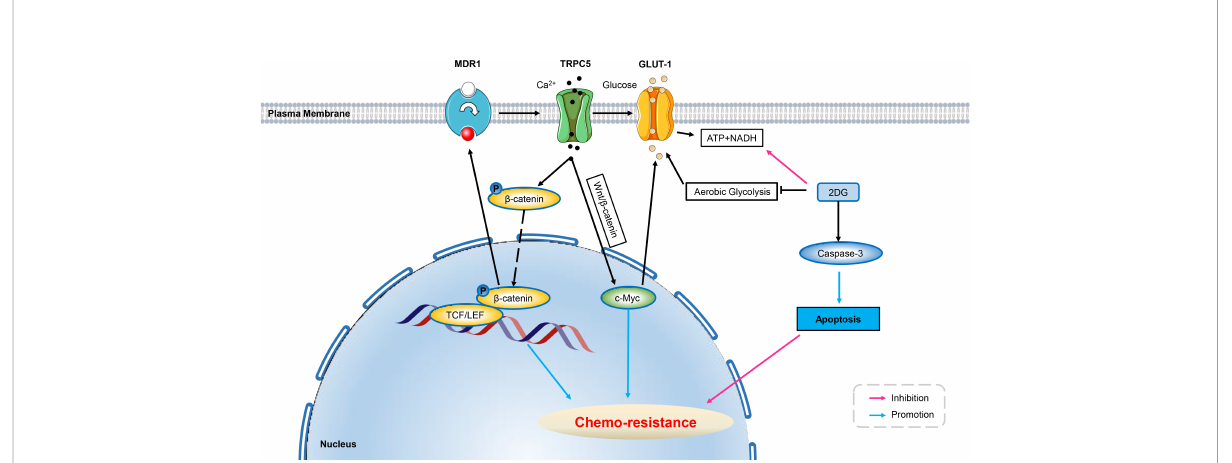
FIGURE 3 Ion channels develop resistance to chemo-therapy involving cell metabolism. Over-expression of TRPC5 leads to increased intracellular Ca 2+ which facilitates the translocation of b -catenin into the nucleus, and induces ABCB1 (MDR1) expression, potentiating resistance to 5-Fu in HCT- 8/5-Fu cells. Up-regulated TRPC5 in human colorectal cancer cells activates the Wnt/ b -catenin signaling pathway, which has been shown to induce GLUT1 expression through its target gene c-Myc, thus exacerbating chemo-resistance. Using glycolysis inhibitor of 2DG can signi fi cantly increase the level of cleaved Caspase-3 in HCT-8/5-FU cells, thereby inducing apoptosis and reverse chemo-resistance. ABCB1, ATP-binding cassette, subfamily B, member 1; GLUT, glucose transporter; 5-Fu, 5-Fluorouracil; 3-BP, 3-bromopyruvate; 2DG, 2-Deoxy-D-glucose; Wnt/ b - catenin, Canonical Wnt/ b -catenin